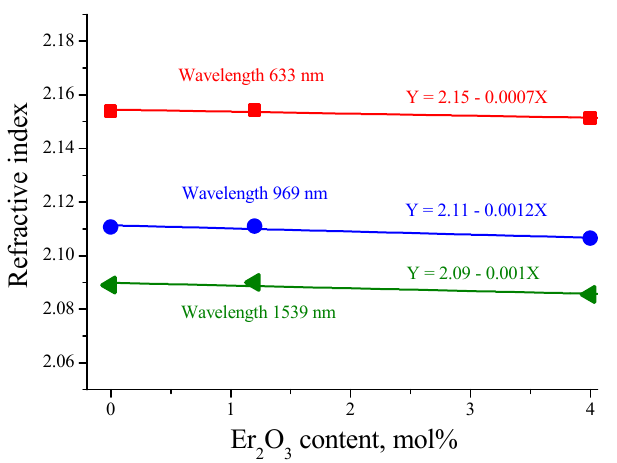
Figure 6. Refractive index of TeO 2 -WO 3 -Bi 2 O 3 -(4-x)La 2 O 3 -xEr 2 O 3 glass samples versus Er 2 O 3 concentration for wavelengths of 633, 969, and 1539 nm.